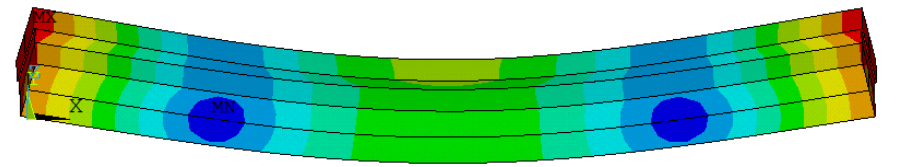
Figure 4. Vibration mode of the double − harmonic piezoelectric composite lamination ( l 1 = 50.3 mm, l 2 = 50 mm).